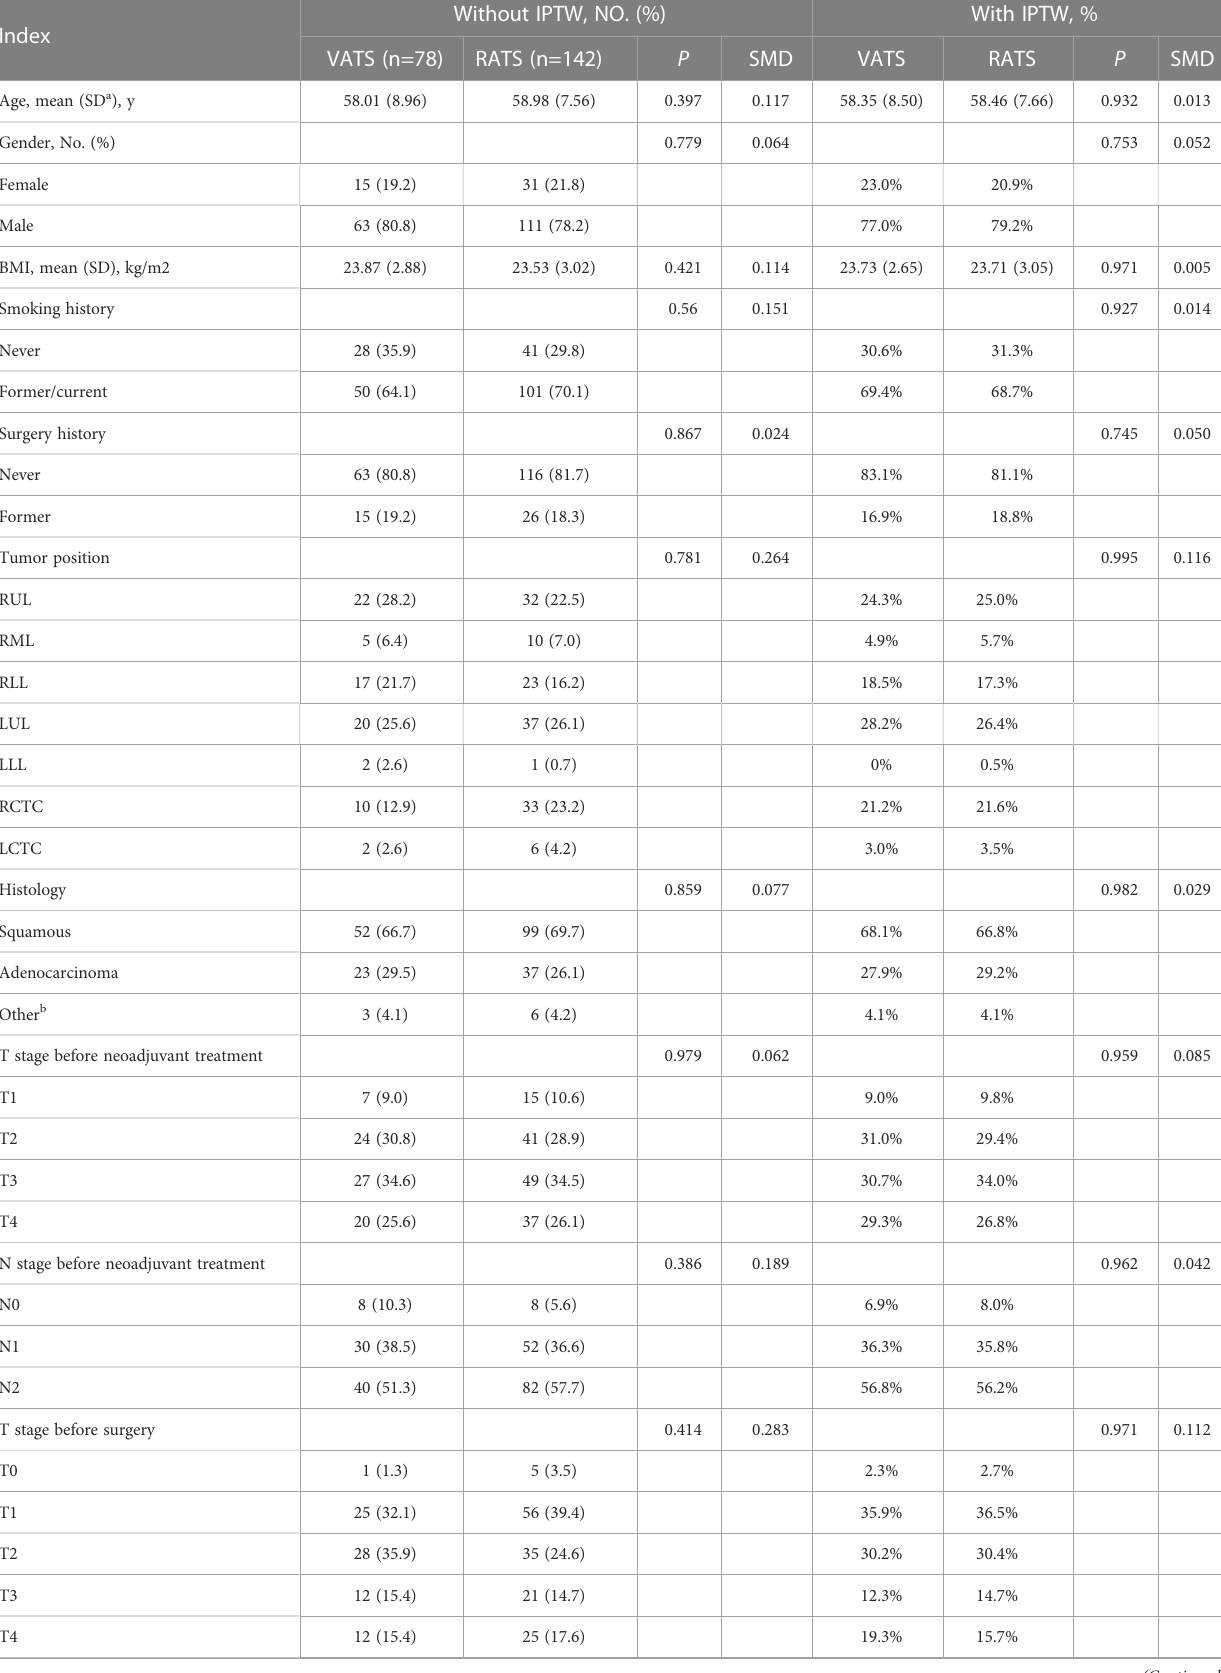
TABLE 1 Unadjusted and IPTW adjusted patient baseline characteristics.